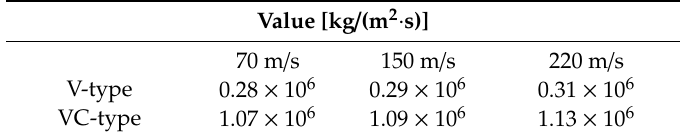
Table 8. Average erosion rates of the two types of bionic coatings at di ff erent impact speeds. Figure 14. Erosion rate curves of bionic coatings at different speeds at 0° angle of attack: ( a ) V P = 70m/s; ( b ) V P = 150 m/s; ( c ) V P = 200 m/s.